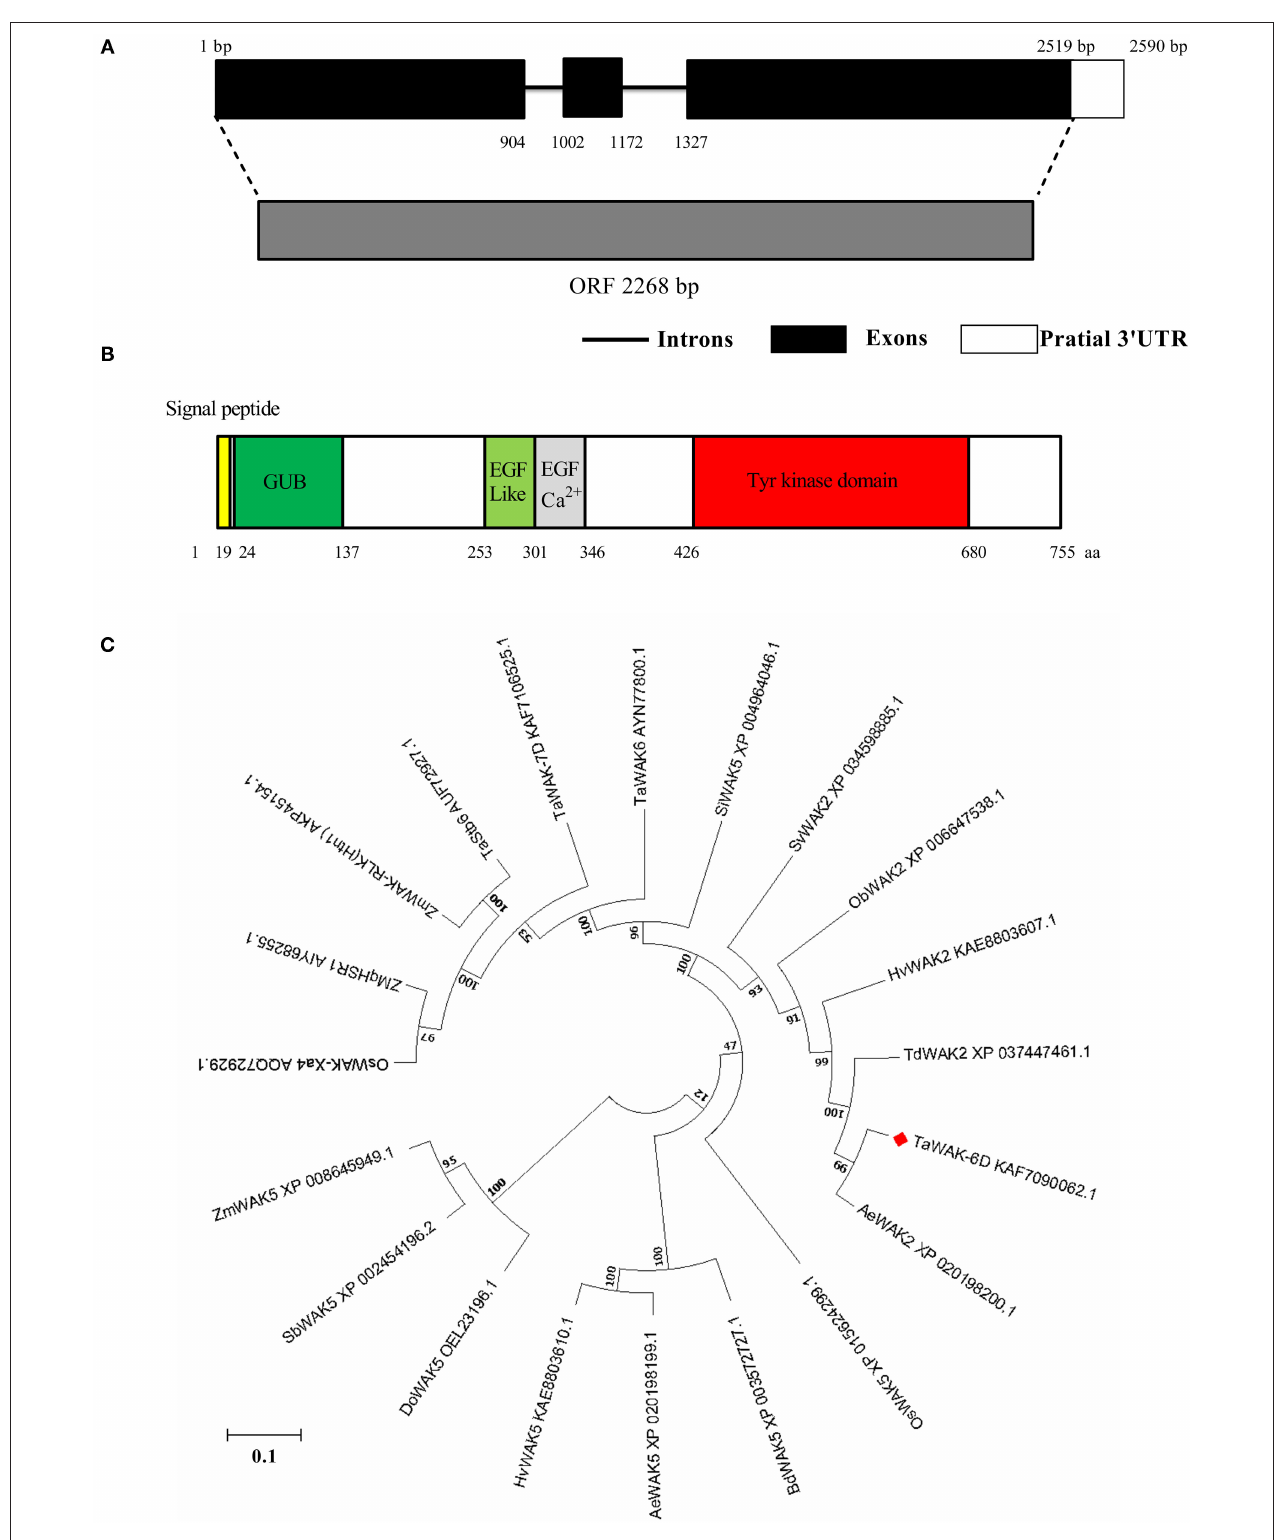
FIGURE 3 | Gene-structure analysis, conserved-domain analysis, and phylogenetic tree construct of TaWAK-6D. (A) Gene structure of TaWAK-6D . Black boxes represent exons, and black lines indicate introns. (B) Schematic diagram of the TaWAK-6D protein. The colored regions indicate different domains. (C) Phylogenetic analysis of TaWAK-6D and 19 other WAK proteins. The neighbor-joining method (MEGA 6.0) was used to construct the bootstrapped phylogenetic tree. The position of TaWAK-6D was indicated with a red blot.